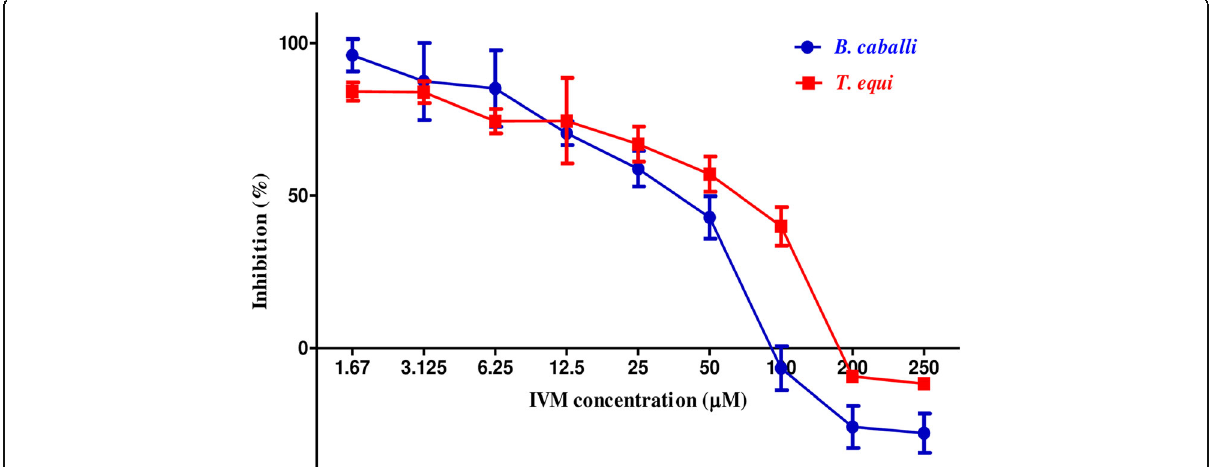
Fig. 2 The dose-response curves of ivermectin against equine piroplasm parasites in vitro. The curve shows the correlation between relative fluorescence units (RFUs) and the log concentrations of IVM ( μ M) in B . caballi and T . equi treated with various concentrations of IVM. The result was determined by fluorescence assay after 96 h of incubation. The values obtained from three separate trials were used to determine the IC 50 s using nonlinear regression (curve fitting analysis) in GraphPadPrism